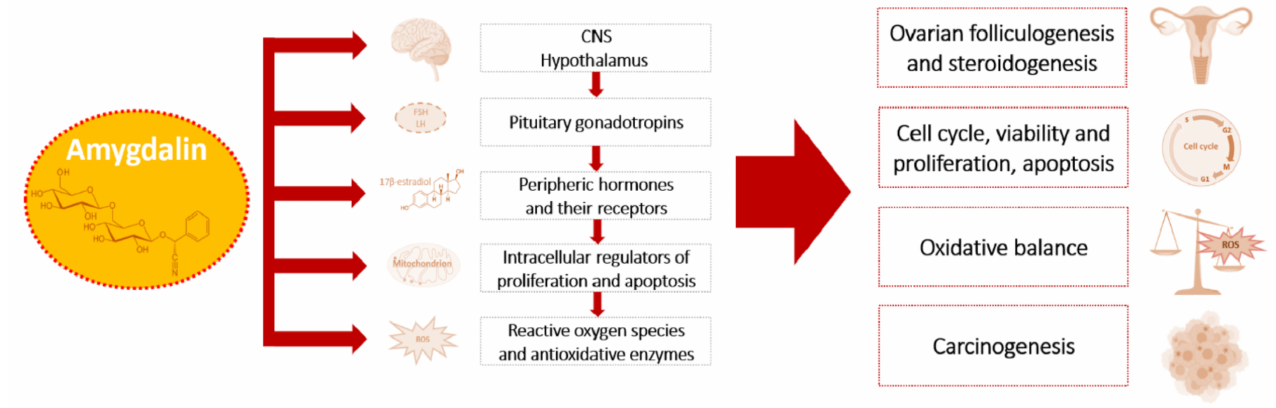
Figure 3. Targets and physiological actions of amygdalin on female reproductive processes and their pathological